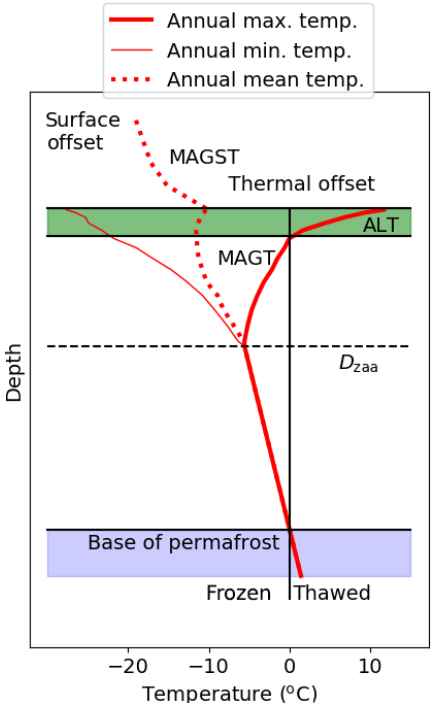
Figure 1. Schematic of the mean, minimum and maximum annual temperature profile from the surface boundary layer to below the bottom of the permafrost. MAAT is the mean annual air temper- ature; MAGST is the mean annual ground surface temperature at 0.2m; MAGT is the temperature at the top of the permafrost; ALT is the seasonal thaw depth in any given year. The surface offset is the difference between the MAAT and the MAGST, and the thermal offset is the difference between the MAGST and the MAGT. D zaa is the depth of zero annual amplitude of ground